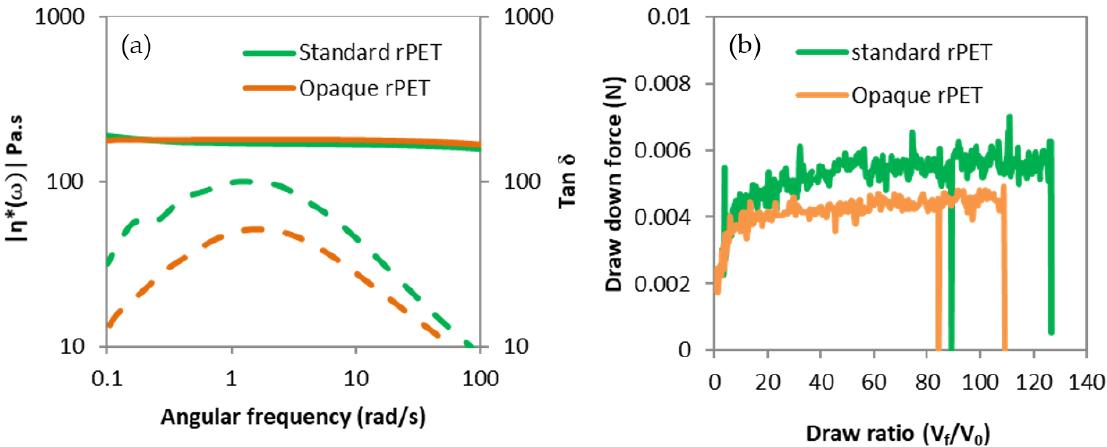
Figure 2. Rheological characterization of standard rPET and opaque rPET raw samples, with ( a ) Absolute complex viscosity and tan δ (dotted line) versus frequency, and ( b ) Draw-down force versus draw ratio. Polymers 2022 , 14 , x FOR PEER REVIEW